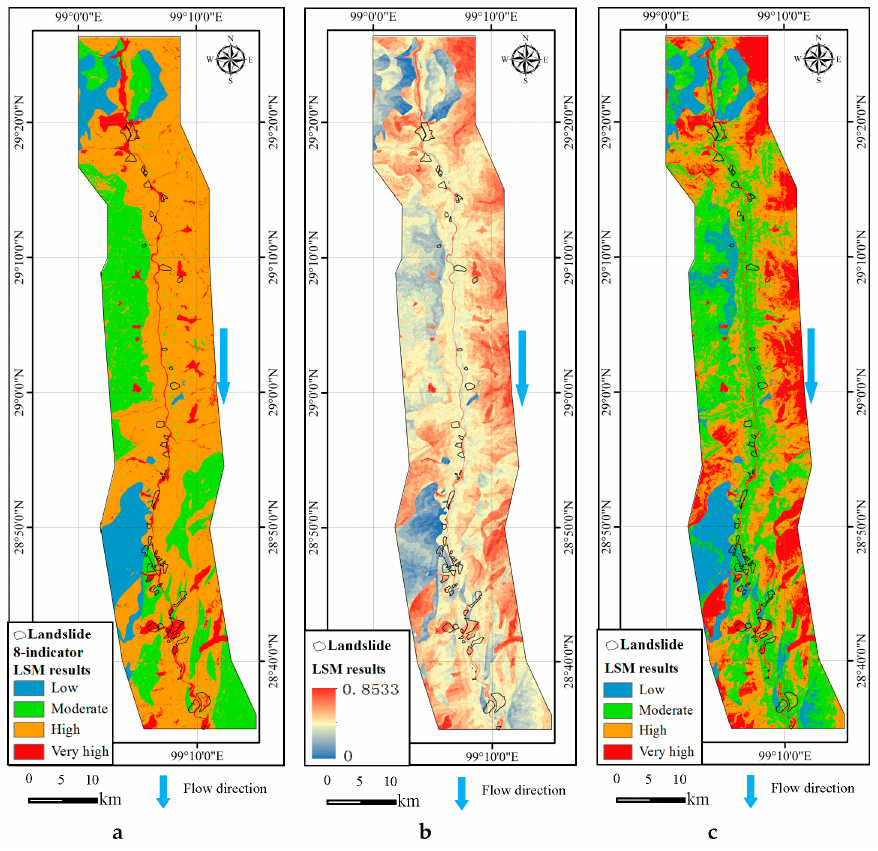
Figure 9. Landslide susceptibility map results using the new approach: ( a ) eight-factor LSM results; ( b ) LSM discrete results; and ( c ) LSM classification results.